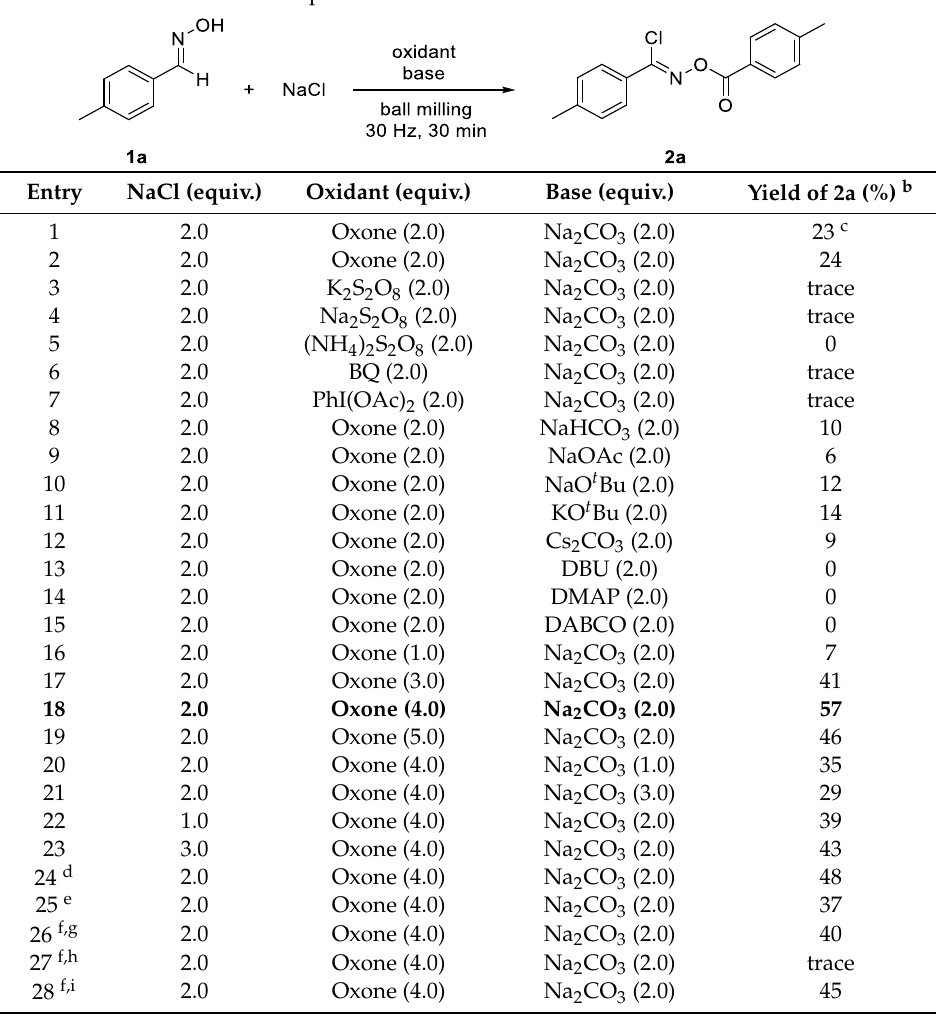
Table 1. Optimization of the reaction conditions a .